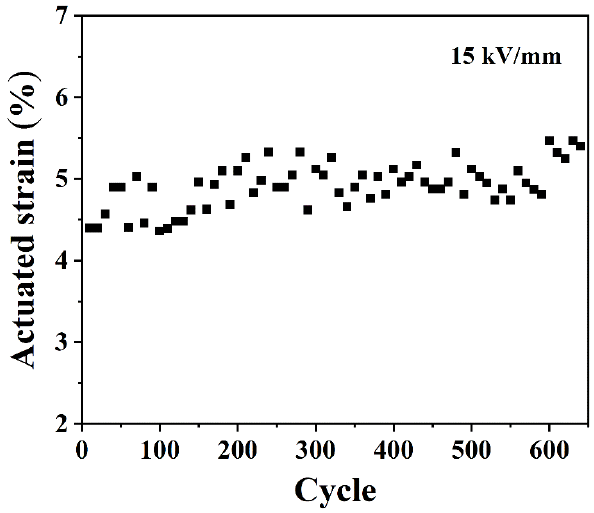
Figure 10. (a ) Actuated strains and ( b ) β of Si747@BTO/ENR composites with various loadings of ESO.